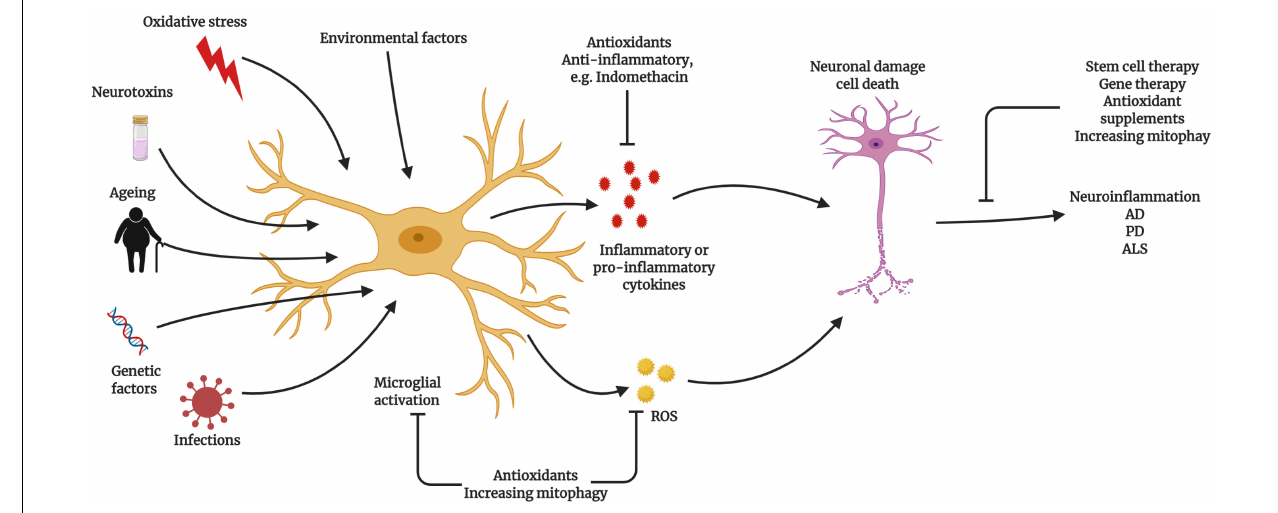
FIGURE 4 | Relationship between microglial activation and neuroinflammatory diseases Microglia become activated due to ageing, exogenous or endogenous infection, oxidative stress, and genetic factors, which can lead to neuroinflammation and neurodegeneration. Activated microglia produce excessive reactive oxygen species (ROS) during ageing, triggering the activation of the nuclear factor (NF)- κ B signaling cascade. Activated microglia trigger neuroinflammation to promote neuronal damage and cell death. The prevention of microglial activation and the normalization of mitochondrial function represent potential therapeutic strategies (Created with